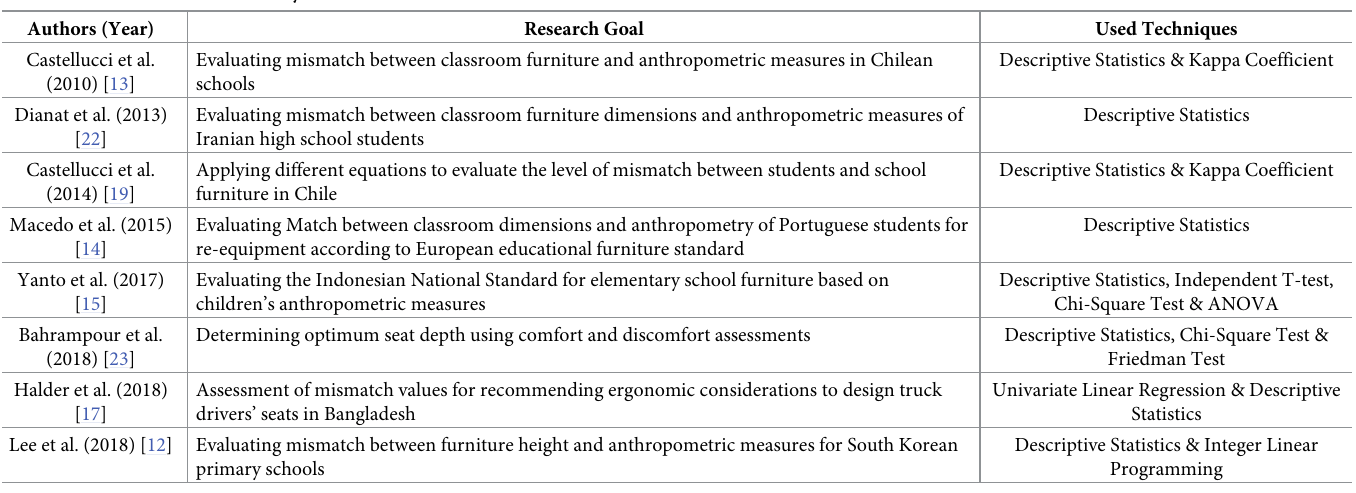
Table 1. Literature review summary about mismatch studies in different